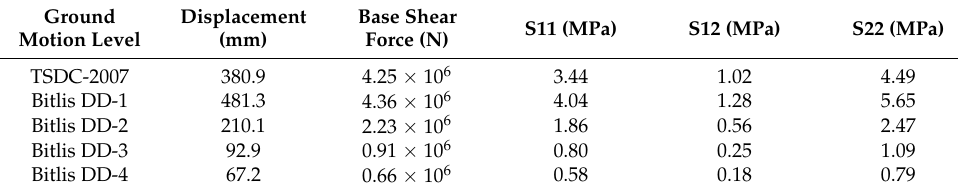
Table 11. The highest values obtained according to different exceedance